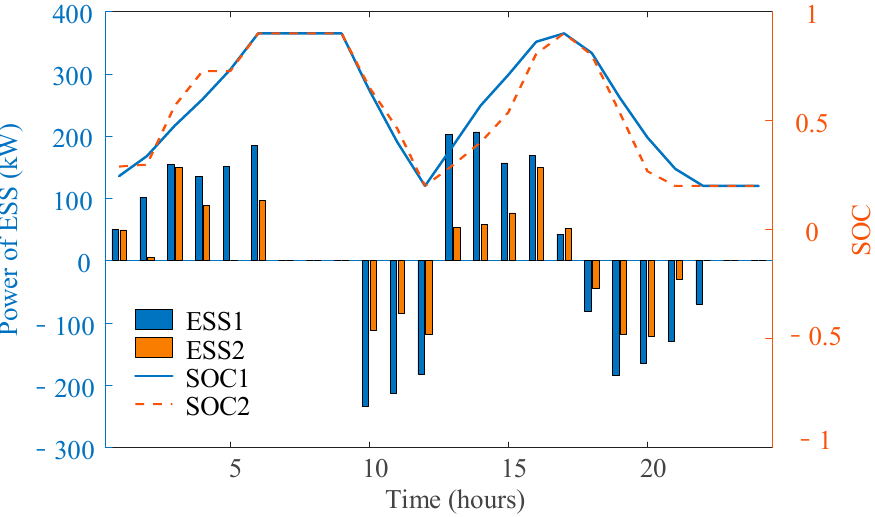
Figure 6. The optimized dispatch results of ESSs for 69-bus distribution network.